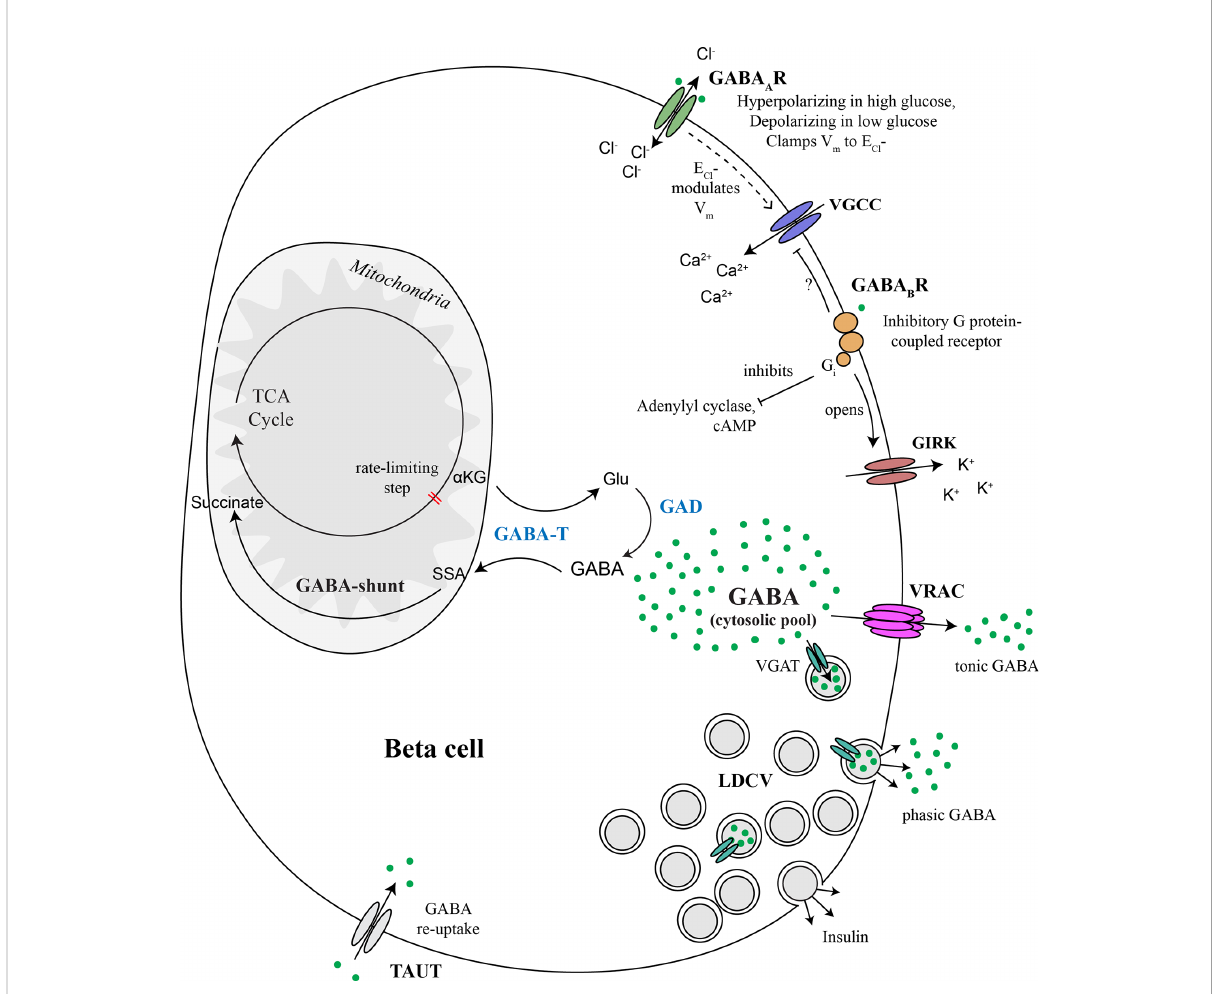
FIGURE 5 Major components of the beta cell GABA system. GABA is synthesized in the cytosol from glutamic acid (Glu) by the enzyme glutamic acid decarboxylase (GAD), of which there are two isoforms, GAD65 and GAD67. GABA is transaminated with alpha ketoglutarate ( a KG) via GABA transaminase (GABA-T) to form glutamic acid (Glu) and succinate semialdehyde (SSA). SSA is in turn oxidized to form succinate, which enters the TCA cycle, thus connecting the GABA pool to beta cell metabolism. GABA is secreted to the extracellular space via volume-regulated anion channels (VRAC), which are a mechanism for non-vesicular secretion of osmolytes GABA and taurine from the cytosolic pool in response to changes in osmolarity or other triggers. This non-vesicular form of GABA release does not appear to be regulated by glucose. GABA is also be secreted from a sub-population of large dense core vesicles (LDCV) together with insulin. Vesicular packaging of GABA depends on the presence of the vesicular GABA transporter (VGAT), which is expressed in only a subpopulation of beta cells. Alternatively, we speculate that VMAT2 could serve as a vesicular GABA transporter in the absence of VGAT, although experimental evidence has not yet been generated to support this concept. Once secreted, interstitial islet GABA ligates GABA A receptors (GABA A R), which are Cl - channels. Chloride currents through opened GABA A Rs modulate membrane potential (V m ) and thus control beta cell excitability. The direction that GABA A R pushes V m depends on whether the V m is presently above or below the equilibrium chloride potential (E Cl -). GABA A R activation can inhibit insulin secretion by clamping V m to the E Cl - or hyperpolarizing the membrane back toward E Cl - when V m is more electropositive in excited beta cells. GABA A R can contribute to beta cell depolarization when glucose concentrations are low and V m is negative of E Cl -. GABA also ligates GABA B receptors (GABA B R), which are inhibitory G protein (Gi)-coupled receptors that stimulate the opening of G protein-coupled inwardly-rectifying potassium channels (GIRKs) and inhibit adenylyl cyclase. Gi is also known to inhibit P/Q-type and N-type and Ca 2+ channels but it is not yet con fi rmed whether this mechanism occurs in beta cells. Overall, the pancreatic islet integrates metabolic, ionotropic, and metabotropic signals together with the paracrine effects of GABA via responses invoked in alpha and delta cells, to result in a net effect of GABA on islet